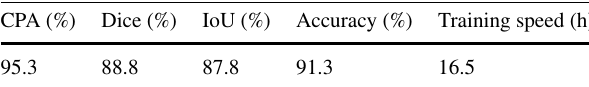
Table 3 Evaluation index of experimental results of the method in this paper